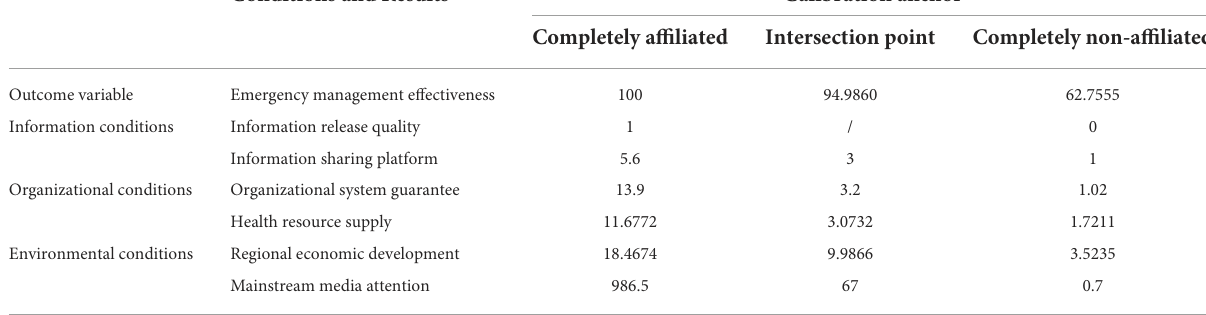
TABLE 2 Calibration of conditions and